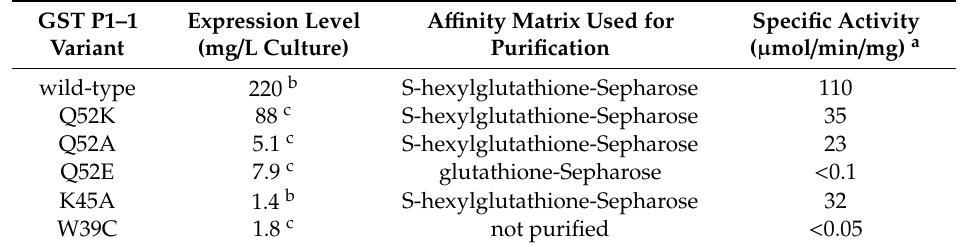
Table 1. Expression levels, purification method, and specific activities of glutathione transferase (GST) P1–1 variants.